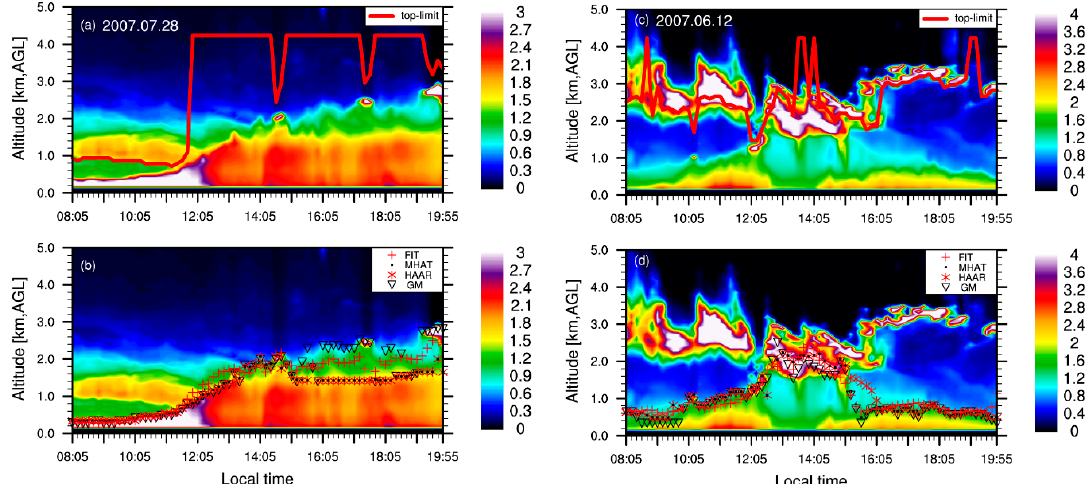
Figure 12. Same as in Figure 8, the top limiter in ( a , c ) represents the upper altitude defined in Dang et al. [56], the ABLH in ( b , d ) determined from the HM, HAAR, MHAT, and CFM below the top limiter. Table 3. Improved versions of some classical methodologies in Table 2 (GM, gradient method; VAR, variance analysis; WCT, wavelet covariance transform; FIT, ideal profile fitting).